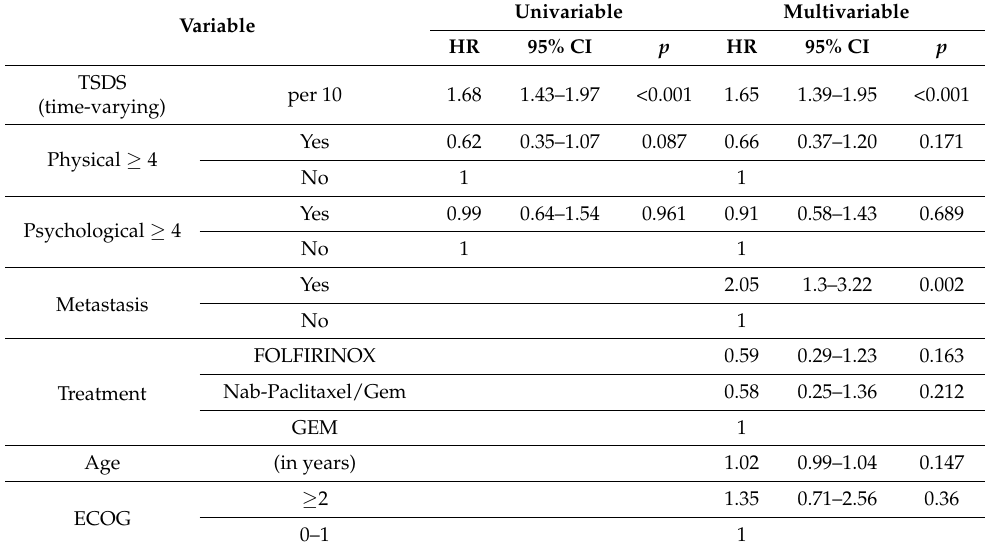
Table 4. Cox regression from joint model predicting survival (baseline measures of physical and psychological scales plus time-varying TSDS). Univariable Variable